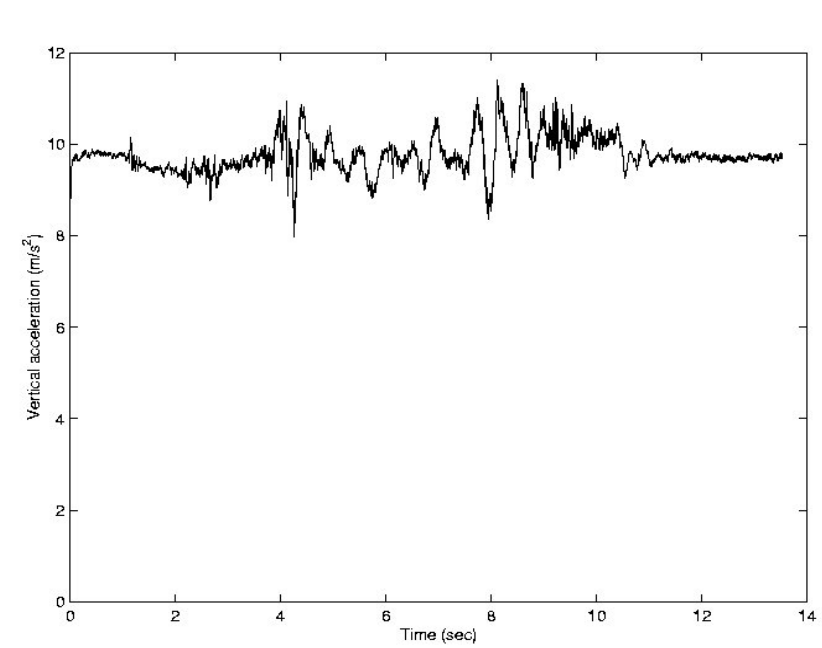
Figure 10. Estimated value of the vertical